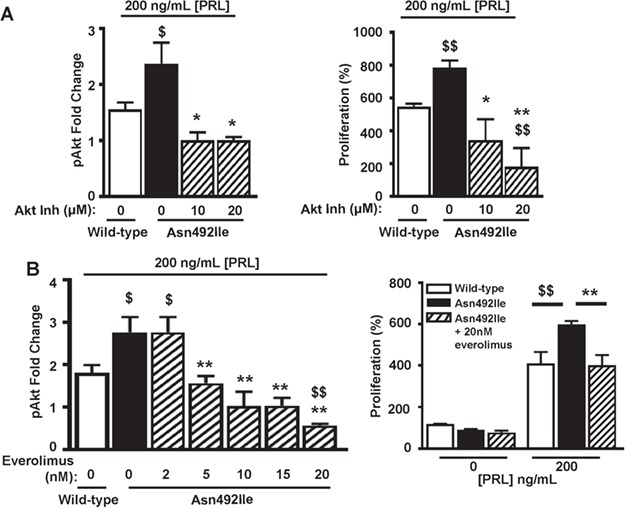
Effects of inhibitors of the Akt signaling pathway on Asn492Ile PRLR-induced proliferation. (A) Effect of the Akt1/2 inhibitor (inh) (1,3-Dihydro-1-(1-((4-(6-phenyl-1H-imidazo[4,5-g]quinoxalin-7-yl)phenyl)methyl)-4-piperidinyl)-2H-benzimidazol-2-one trifluoroacetate salt hydrate) on pAkt responses (left panel) and 96 h proliferation (right panel) in HEK293 cells expressing WT and Asn492Ile PRLR and treated with 200 ng/mL PRL. The Akt inhibitor reduced pAkt responses and proliferation in Asn492Ile PRLR-expressing HEK293 cells such that they were not significantly different to WT cells. (B) Effect of the mTOR inhibitor, everolimus, on pAkt responses (left panel) and 96 hour proliferation (right panel) in WT and Asn492Ile PRLR-expressing HEK293 cells treated with 200 ng/mL PRL. Everolimus reduced pAkt responses and proliferation in Asn492Ile PRLR-expressing HEK293 cells such that they were not significantly different to responses in WT cells. Untreated WT (open bars) and mutant (filled bars) PRLRs, and inhibitor-treated mutant PRLRs (hatched bars). Mean ± SEM from four biological replicates shown with $P < 0.05, *P < 0.05, $$P < 0.02 and **P < 0.02 for comparisons to WT (dollar) and comparisons to Asn492Ile (asterisk).